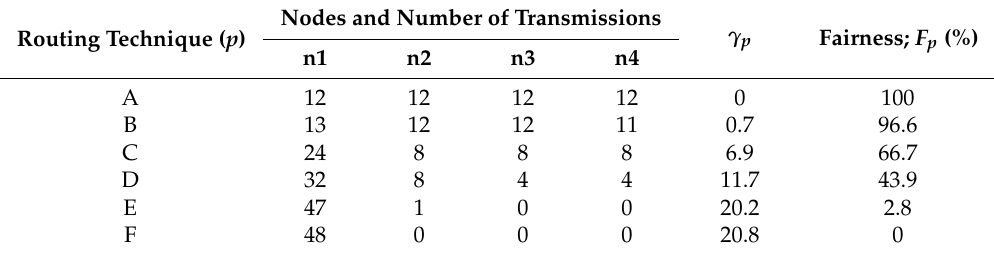
Table 3. Six fictitious routing techniques for describing the working principle of the fairness metric and illustrating how it interprets